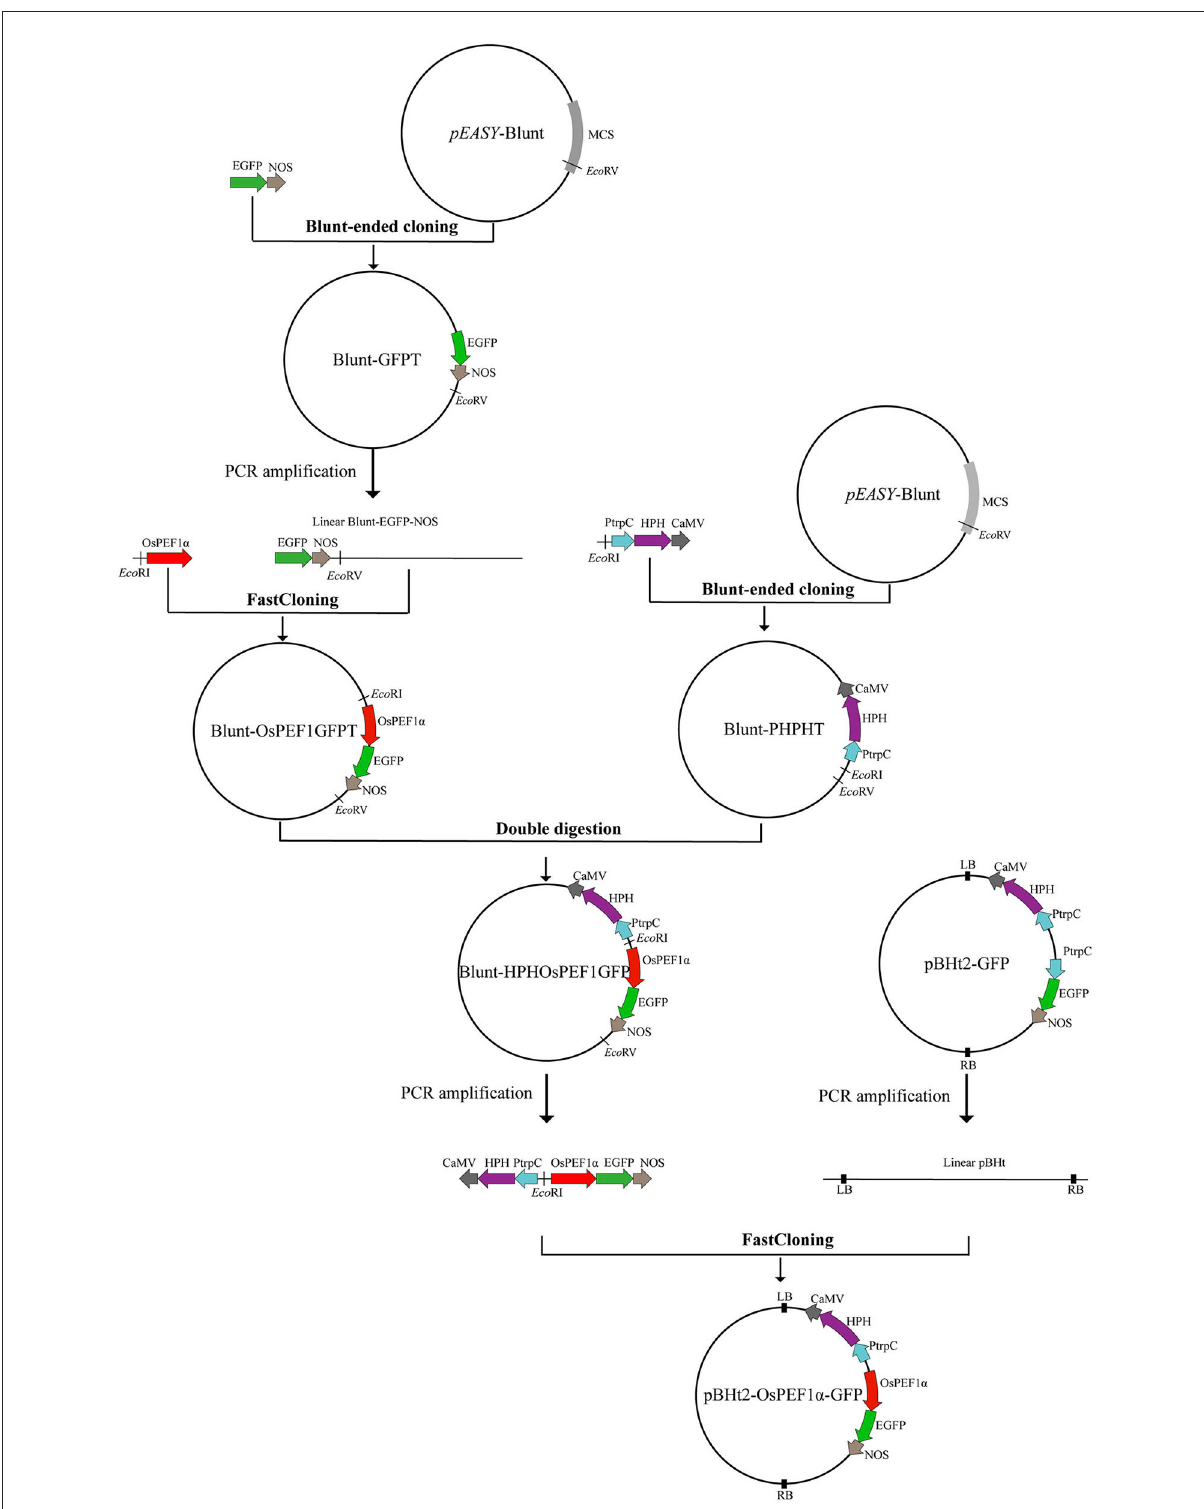
FIGURE1 Flowchart for constructing plasmid pBHt2-OsPEF1 α -GFP. Blunt-ended cloning, FastCloning, and restriction enzyme double digestion methods were used to construct the plasmid pBHt2-OsPEF1 α -GFP. The pEASY -Blunt cloning vector is an intermediate vector. MCS, multiple cloning site. The plasmid pBHt2-OsPEF1 α -GFP contains two gene expression cassettes: the hygromycin B phosphotransferase enzyme ( HPH ) gene cassette with the Aspergillus nidulans trpC promoter and CaMV 35S terminator and the EGFP gene cassette with the Ophiocordyceps sinensis EF1 α promoter and NOS